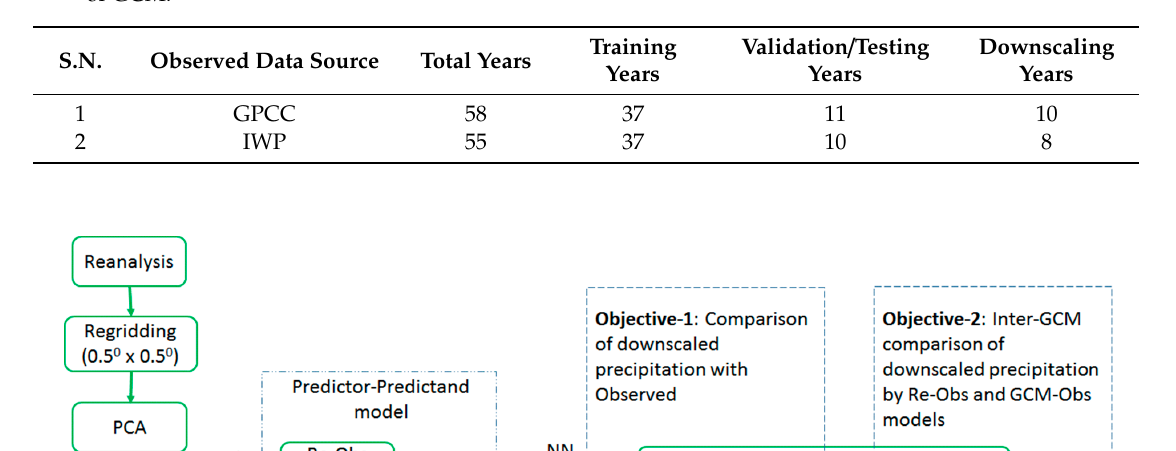
Table 7. Division of data for development of predictor-predictand relationship and downscaling of GCM.